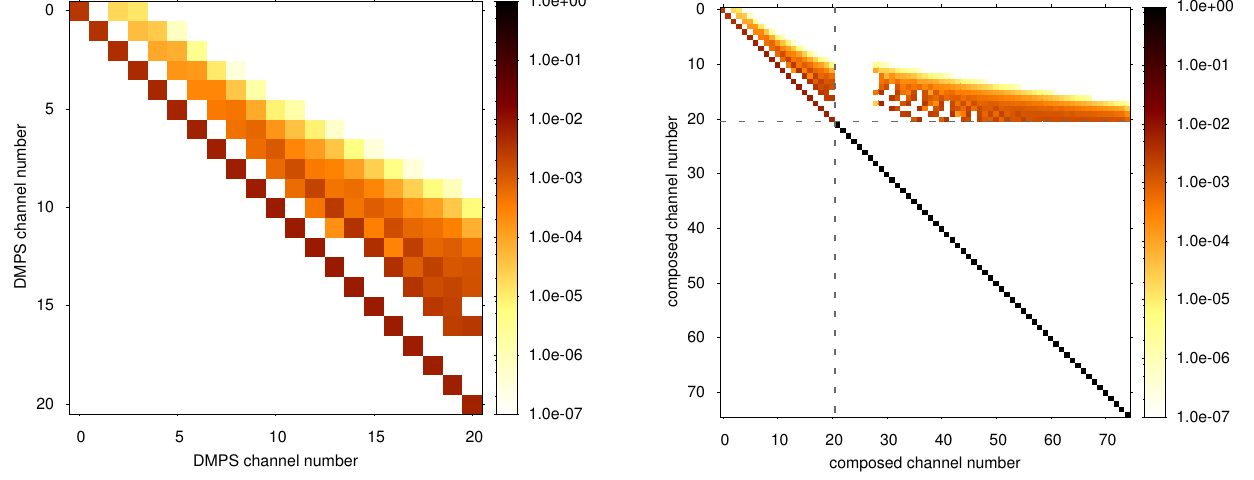
Fig. 5b. Visualization of the multiple-charge matrix for the en- hanced case. The first quadrant corresponds to the matrix entries shown in Fig. 5a. The second quadrant describes the charge correc- tion of the EPMD of the mobility particle size spectrometer with Fig. 5b: Visualization of the multiple charge matrix for the information from additional sensors such as an APS or OPC. The enhanced case. The first quadrant corresponds to the matrix gap for the first entries of the second quadrant is due to the finite entries shown in Fig. 5a. The second quadrant describes the overlap of both sizing charge correction of the EPMD of the mobility particle size spectrometer with information from additional sensors such as an APS or OPC. The gap for the first entries of the second quadrant is due to the finite overlap of both sizing sensors.